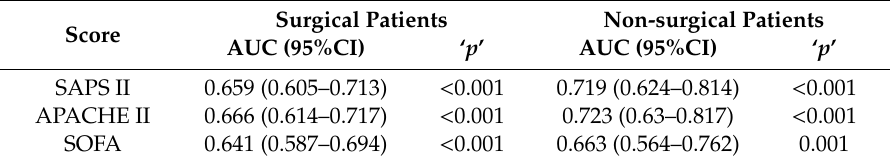
Table 5. Diagnostic accuracy of SAPS II, APACHE II, and SOFA scales in post-ICU mortality prediction among surgical and nonsurgical ICU surviving